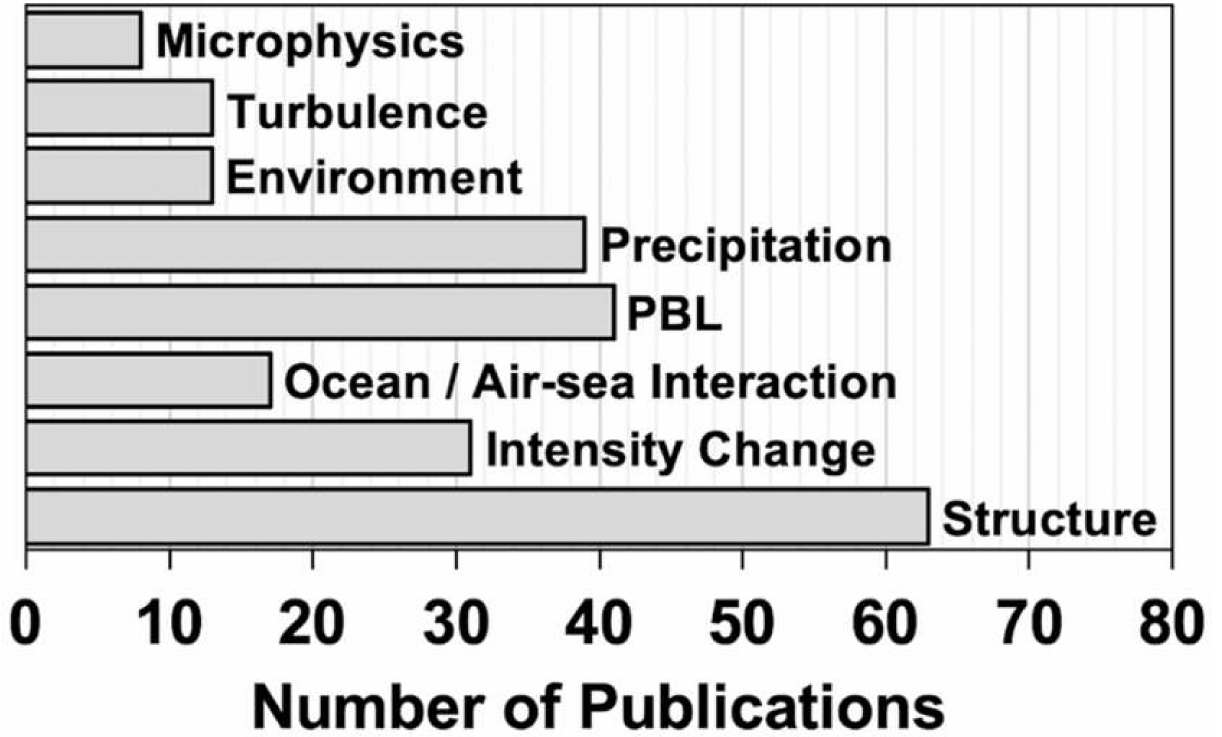
Figure 20. Number of publications from 2006–2020 using NOAA IFEX aircraft data that include NOAA/AOML/HRD and affiliated scientists, stratified by primary TC physical process topic addressed. Adapted from